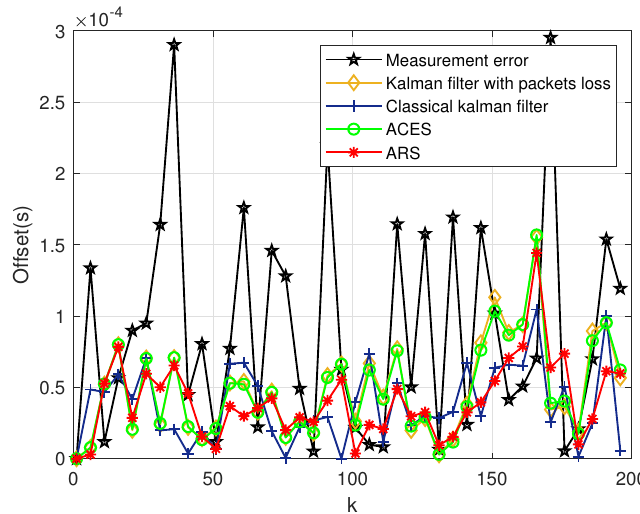
Figure 5. Clock Offset Error of the First-order Kalman Filter.